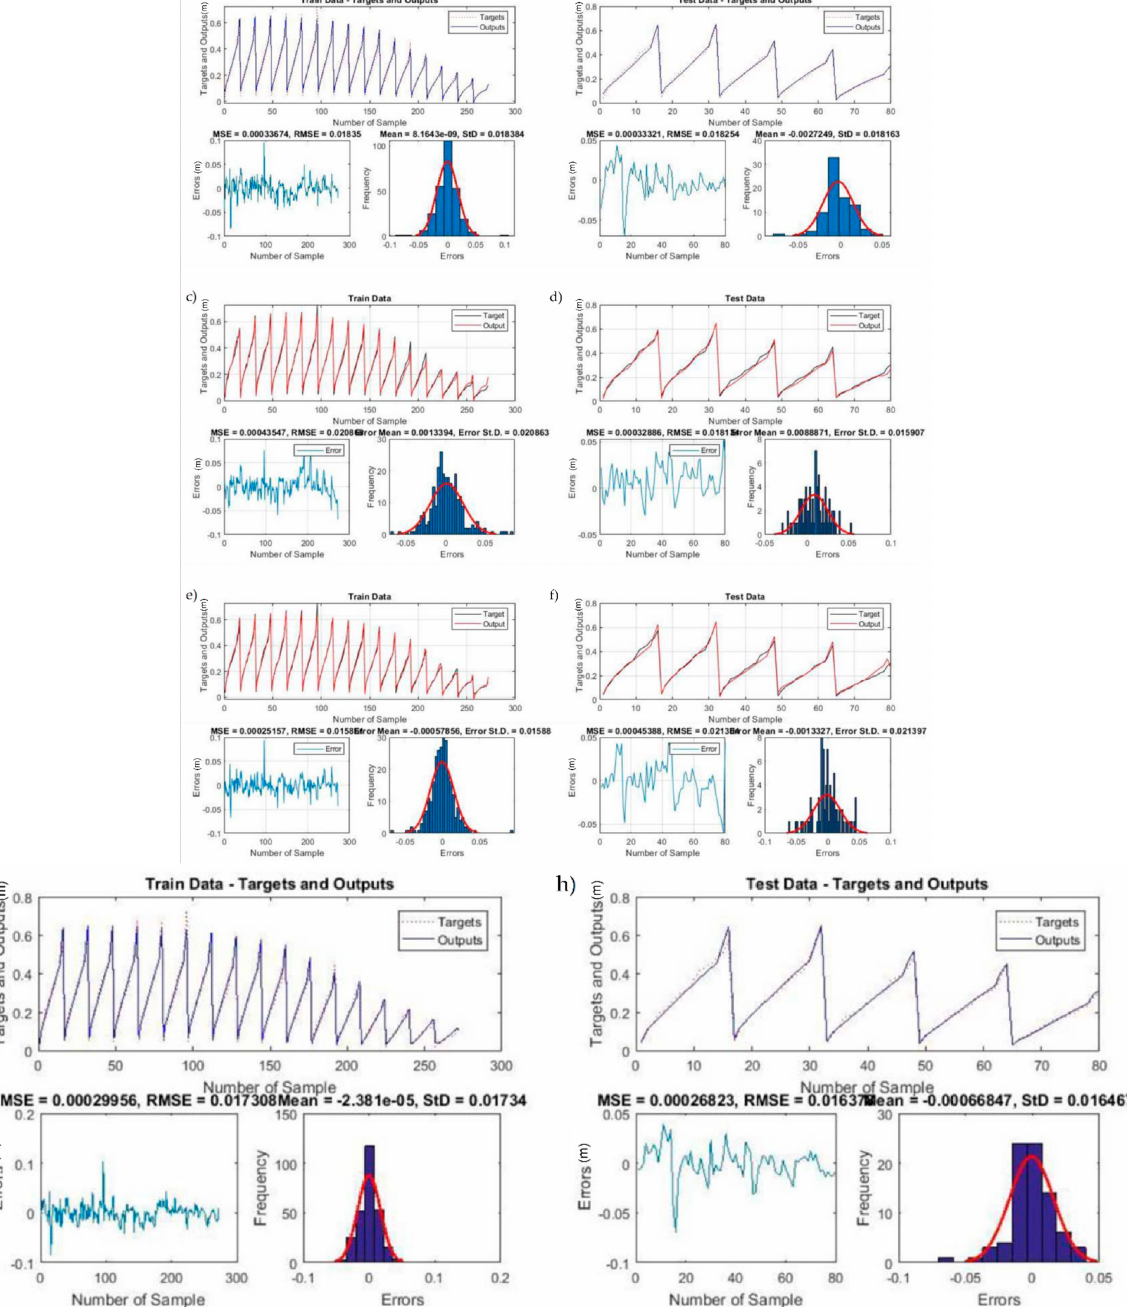
Figure 9. For output x m , ANFIS Model ( a ) targets and outputs, RMSE, MSE values and frequency vs. errors graphs for train data set ( b ) targets and outputs, RMSE, MSE values and frequency vs. errors graphs for test data set. ANFIS-GA: ( c ) targets and outputs, RMSE, MSE values and frequency vs. errors graphs for train data set ( d ) targets and outputs, RMSE, MSE values, and frequency vs. errors graphs for test data set. ANFIS-PSO: ( e ) targets and outputs, RMSE, MSE values and frequency vs. errors for train data set ( f ) targets and outputs, RMSE, MSE values, and frequency vs. errors for test data set. ANFIS-FFA: ( g ) targets and outputs, RMSE, MSE values and frequency vs. errors for train data set ( h ) targets and outputs, RMSE, MSE values, and frequency vs. errors for test data